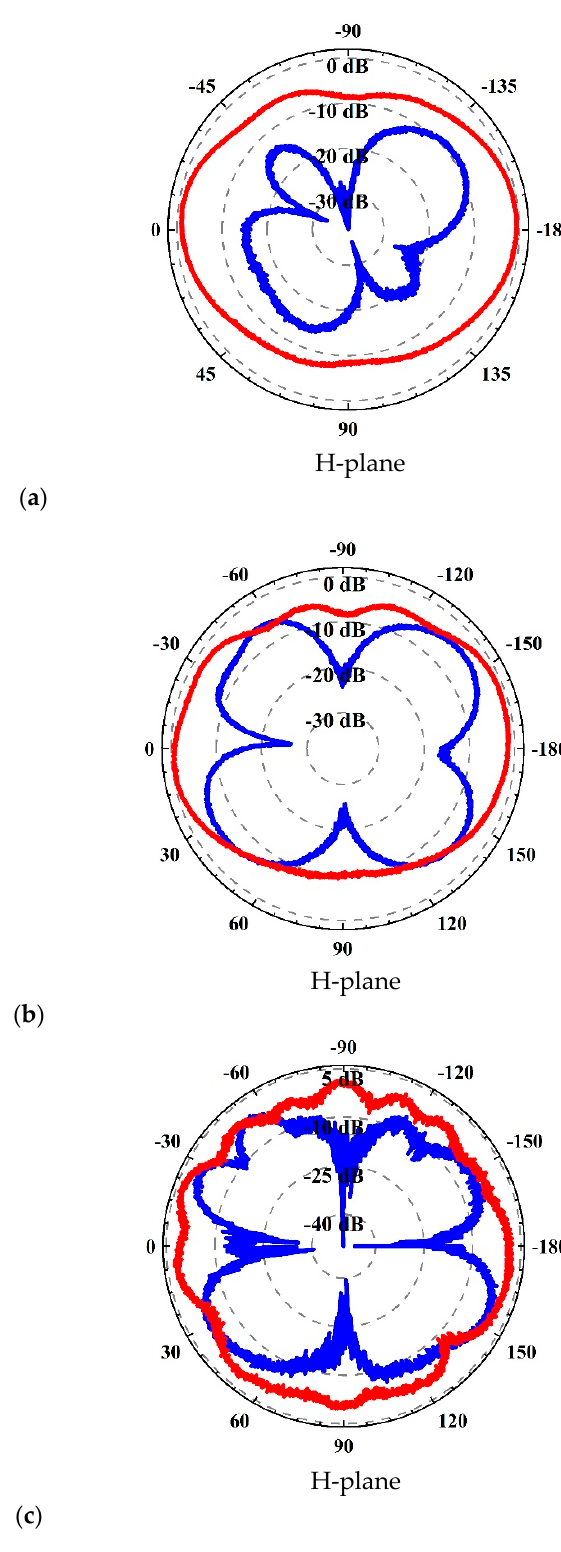
Figure 9. Normalized E-plane and H-plane radiation patterns. ( a ) f = 2 GHz; ( b ) f = 3.5 GHz; ( c ) f = 5 GHz. Red color indicates coplanar polarization, and blue color indicates cross polarization.